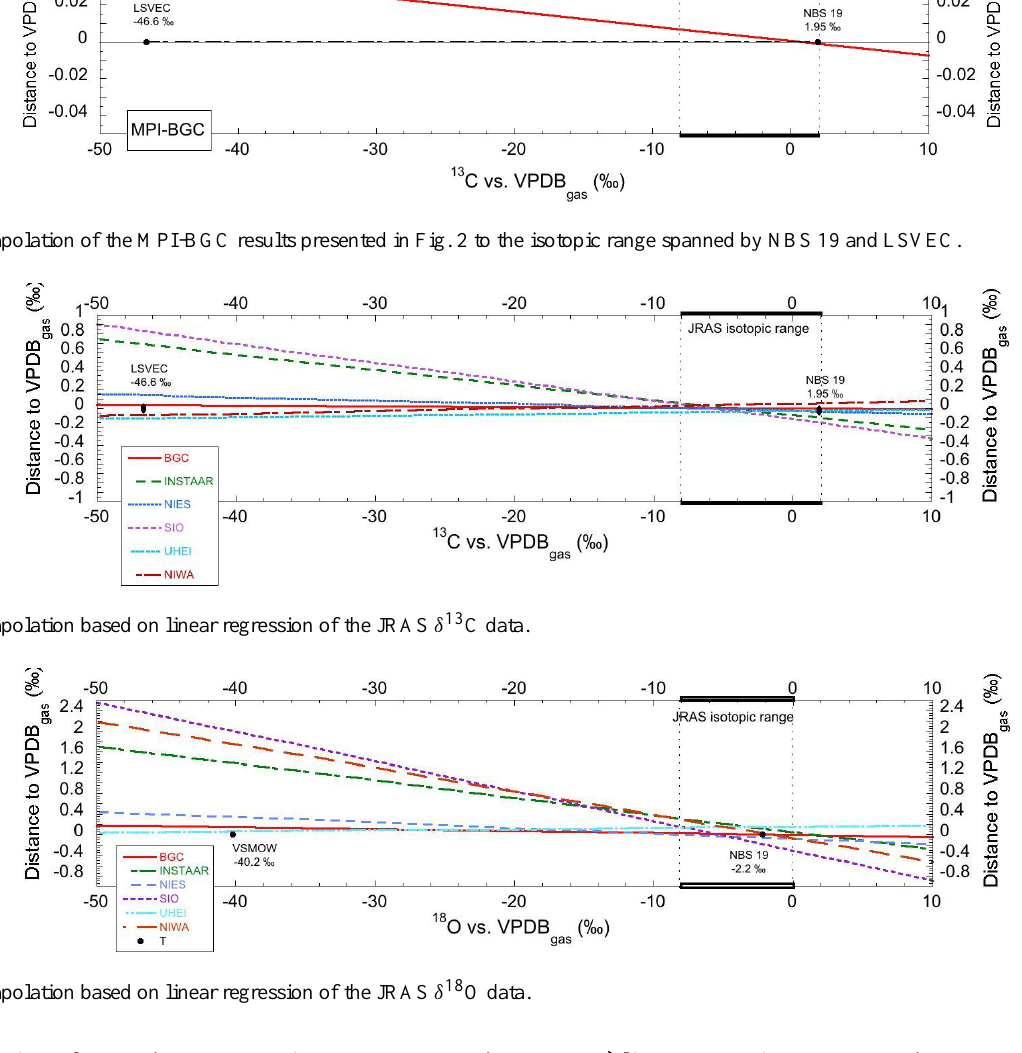
Table 2.  13 C results. Linear regression resulting from comparing local scales to JRAS-06.